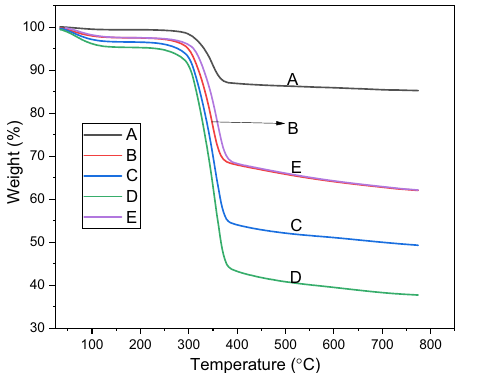
Fig. 3 DTA of arti fi cial teeth Group A – E